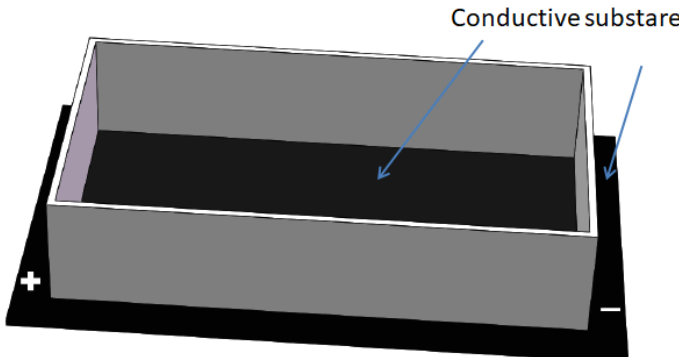
Figure 2. Conductive substrate mediated ES where the cells are cultured on the substrate and exposed to the potential gradient on substrate surface.